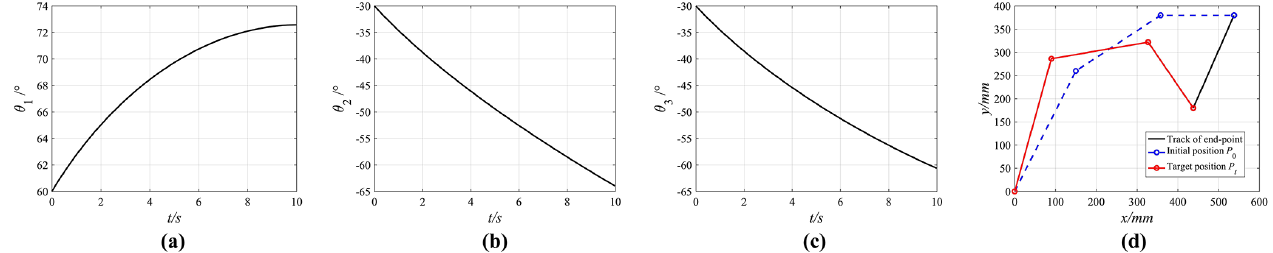
Figure 20. Motion curves of the joints and the manipulator (3 DOFs). (a) The first joint. (b) The second joint. (c) The third joint. (d) Trajec- tory of the manipulator.